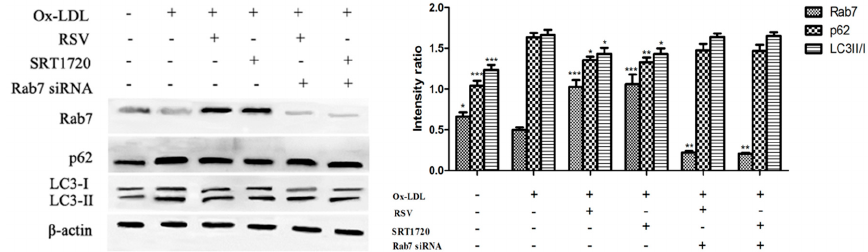
Figure 5. E ff ect of gene silencing Rab7 on the expression of Rab7, LC3-II / I and p62. HUVECs were transfected with the Rab7 siRNA for 24 h incubated with 100 µ g / mL ox-LDL and 10 µ M RSV or 5 µ M SRT1720 for 12 h. Expression of Rab7, LC3-II / I and p62 in HUVECs treated with RSV or SRT1720 was determined by Western blot. Values are presented as the means ± SD ( n = 3). Statistical significance between the ox-LDL treated group and other groups was determined by one-way ANOVA: Compared with the ox-LDL group, * p < 0.05, ** p < 0.01, *** p < 0.001.